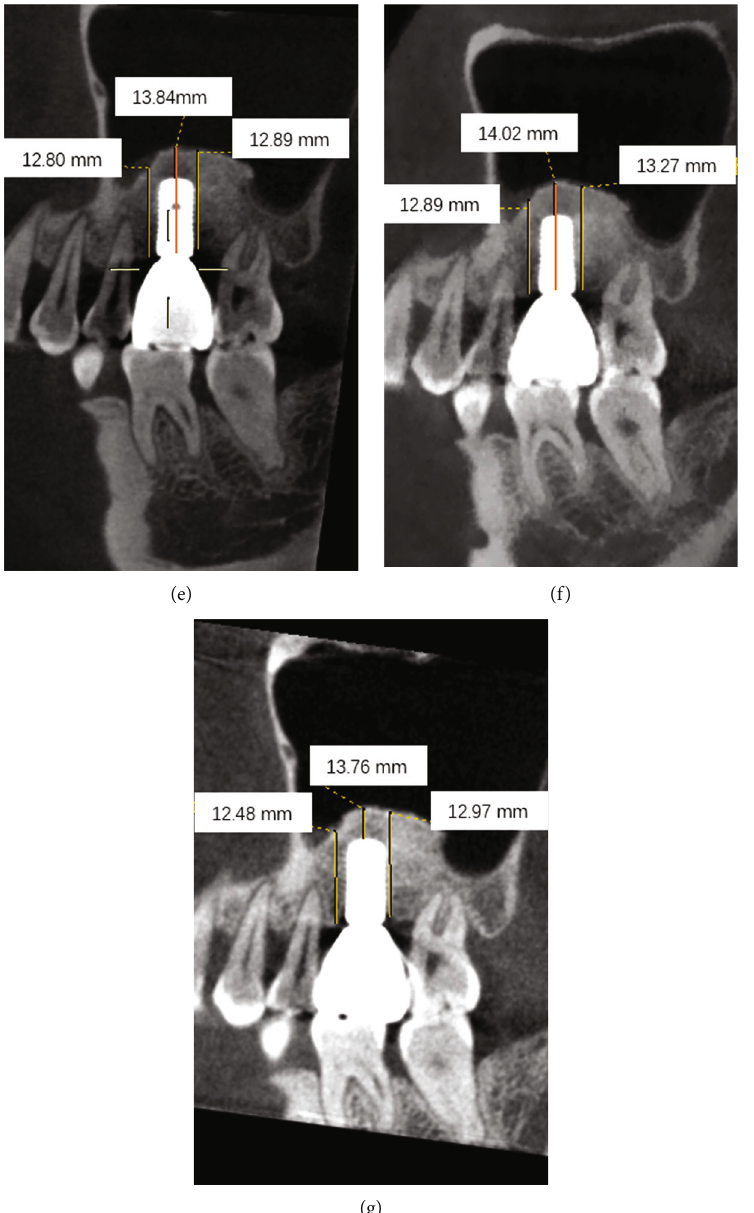
Figure 8: CBCT and pantomograph follow-up for tooth #26. (a) Before MSFE. (b) Immediately after MSFE (pantomograph). (c) 3 months after MSFE (pantomograph). (d) 7 months after MSFE. (e) 14 months after MSFE. (f) 20 months after MSFE. (g) 32 months after